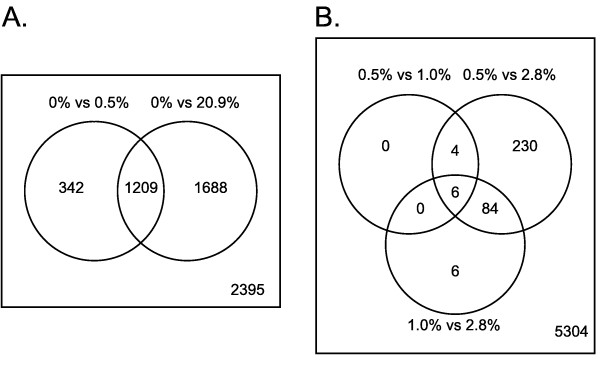
Venn diagrams of the genes which differ significantly (p < 0.01) in conditions of different oxygen provision in the feed gas. A. Anaerobic and either 0.5 or 20.9% oxygen in the feed gas and B. 0.5% and 1.0%, 0.5% and 2.8%, and 1.0% and 2.8% oxygen in the feed gas. The number in the lower right corner of the figures A and B represents the number of genes that were not differentially expressed.